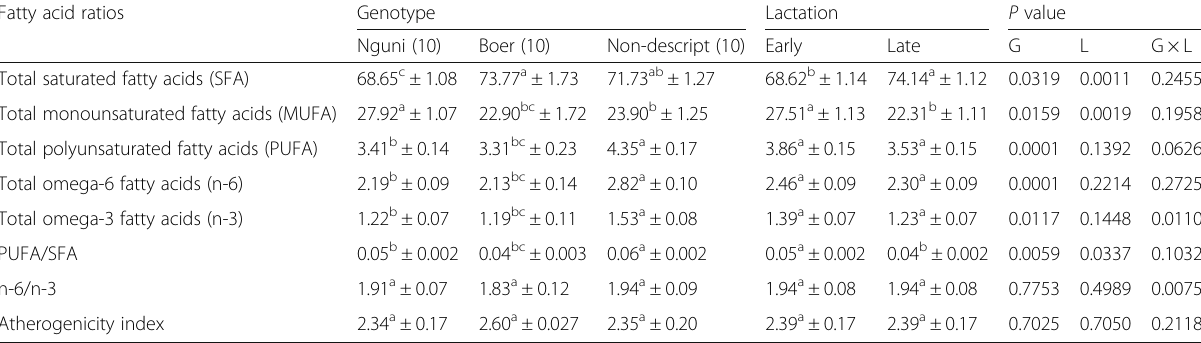
Table 3 Effect of genotype, lactation stage and interaction between genotype and lactation stage on selected classes of fatty acid, ratios and atherogenicity index of milk from free-ranging indigenous goats Fatty acid ratios Genotype Total saturated fatty acids (SFA)